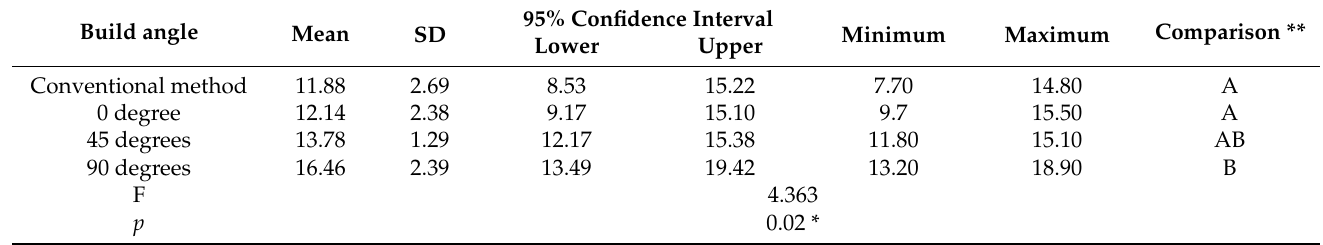
Table 3. Comparison of the wear of interim crowns fabricated according to build angle (RMS ( µ m)).